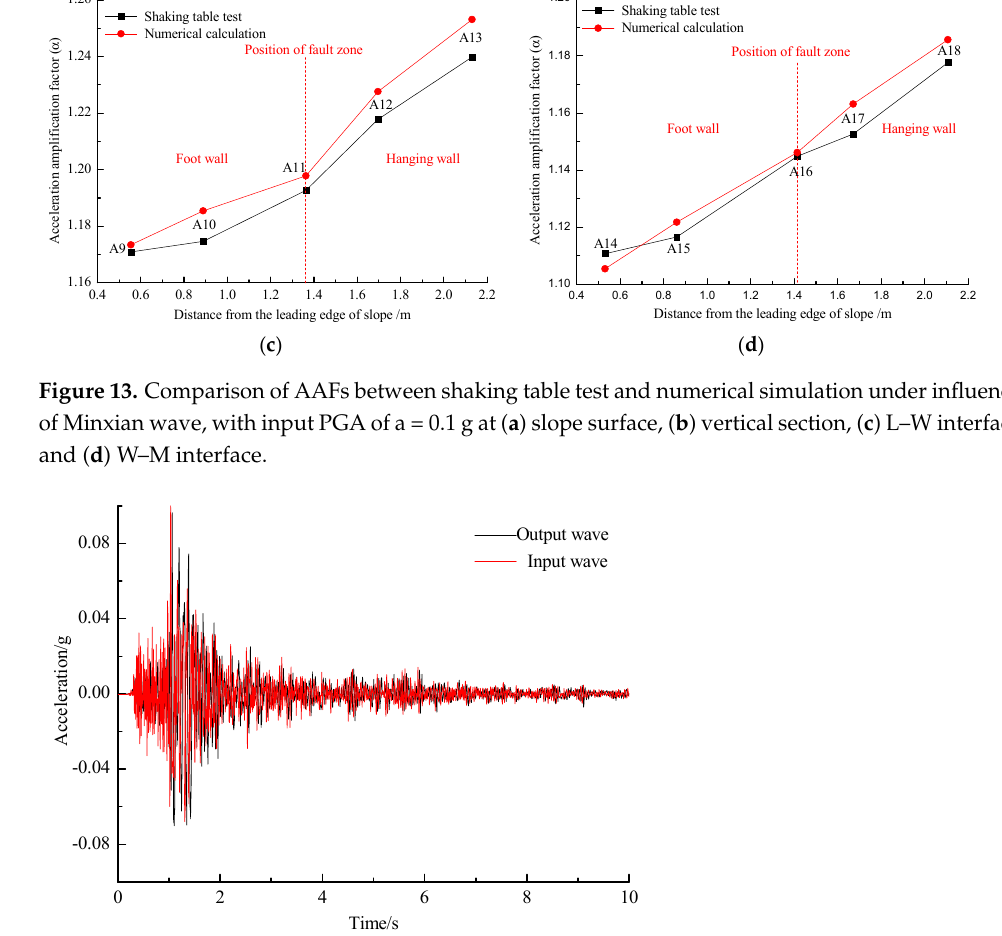
Figure 14. Input and output acceleration time history curves.